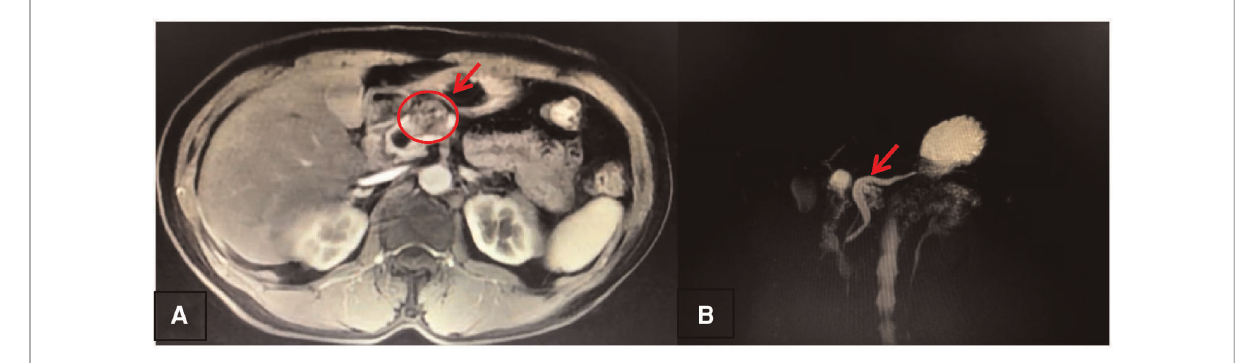
FIGURE 1 A : Magnetic resonance imaging. B : Magnetic resonance